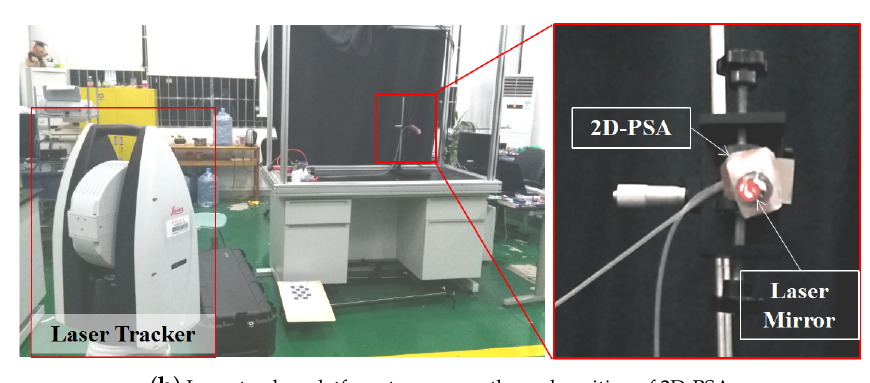
Figure 6. Setup for measurement of the bending angle using a laser tracker and IMU